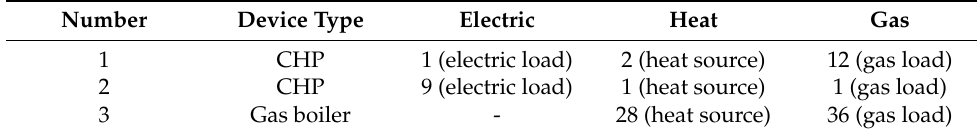
Table 2. Types and locations of the coupling devices.